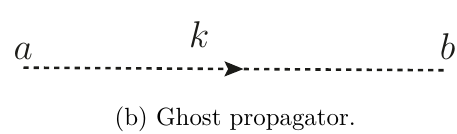
Figure 2 . Two-point